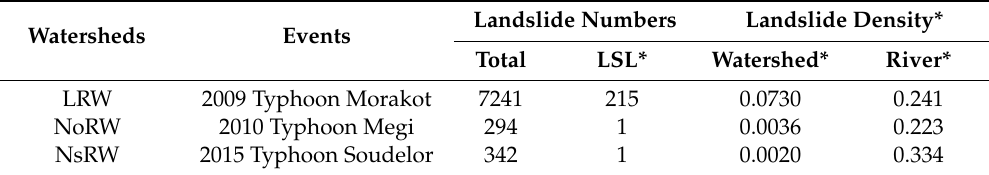
Table 2. The statistical data of landslide inventories in the three watersheds. Watersheds